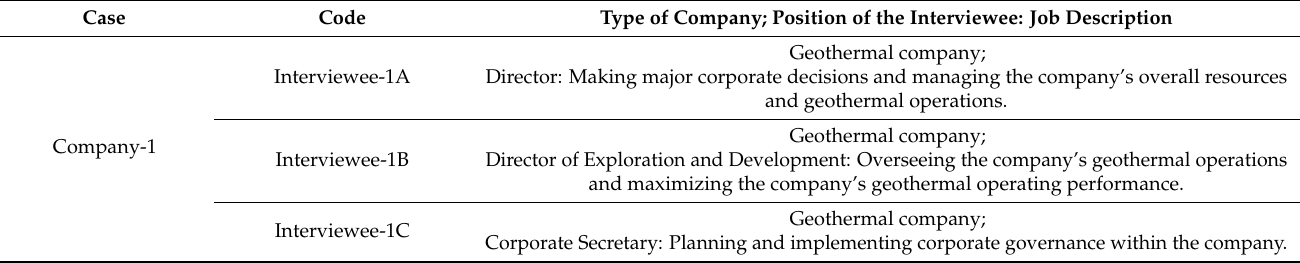
Table 1. List of the case companies and